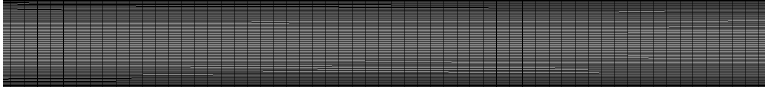
Figure 6. A schematic view of 2D computational domain of the y and z plane.